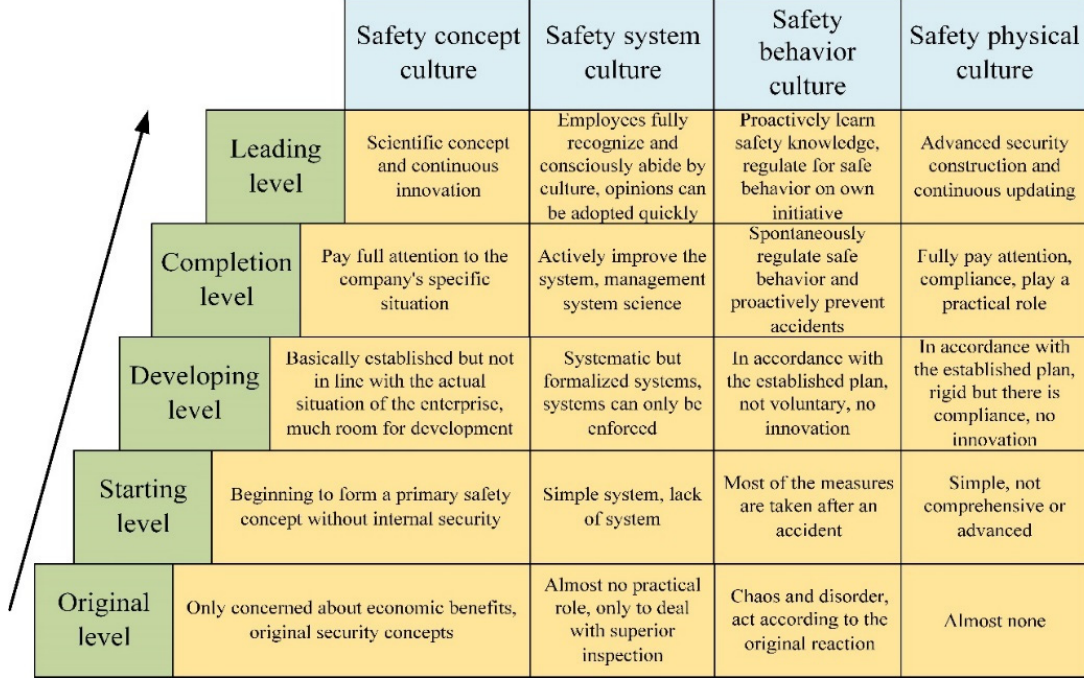
Figure 3. Maturity Level of Safety Culture.